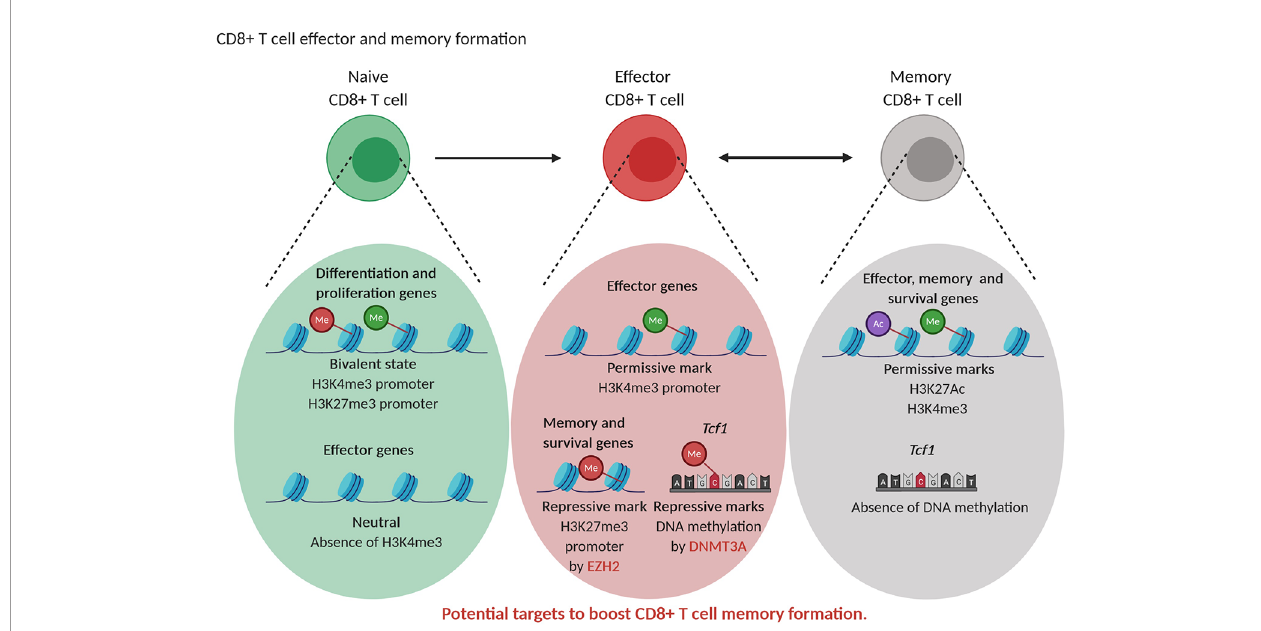
FIGURE 5 | Epigenetic regulation of CD8 + T cell differentiation. Naive CD8 + T cells are characterized by a bivalent state of permissive (green) and repressive (red) histone marks in genes related to differentiation and proliferation while effector genes are not decorated by permissive marks or repressive marks. Effector CD8 + T cells show permissive (green) marks in effector genes while the transcription factor Tcf1 and memory and effector genes contain repressive (red) marks. Memory CD8 + T cells show permissive (green, purple) marks in effector, memory and survival genes while Tcf1 is not DNA methylated, supporting their multipotent state. EZH2 and DNMT3A represent potential targets to increase CD8 + T memory formation.